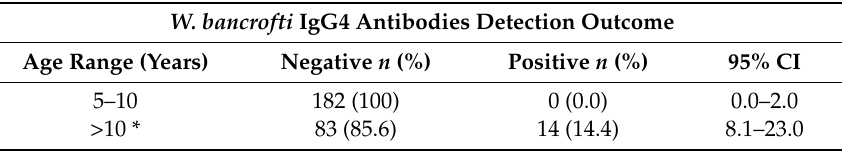
Table 7. Prevalence of W. bancrofti IgG4 antibodies by age group.